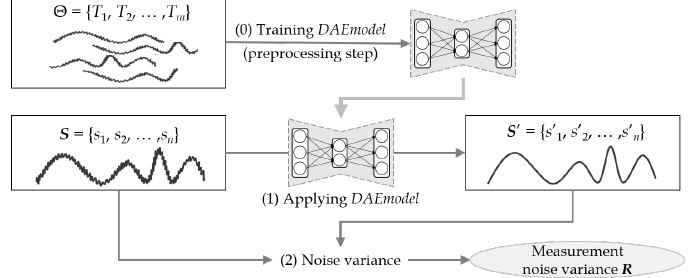
Figure 5. Measurement noise variance estimation using a denoising autoencoder.